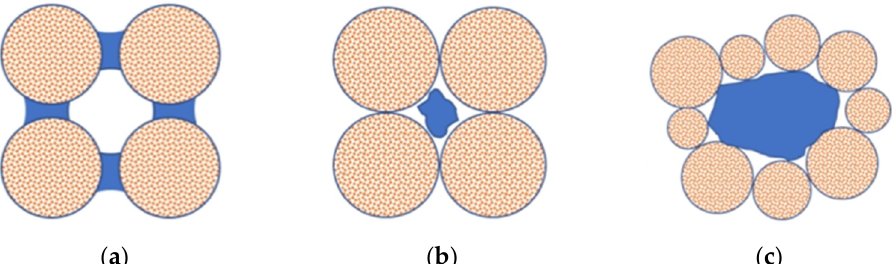
Figure 1. Different types of morphology for methane hydrate bearing sediments [1]. ( a ) Cementation; ( b ) pore filling; ( c ) supporting matrix.